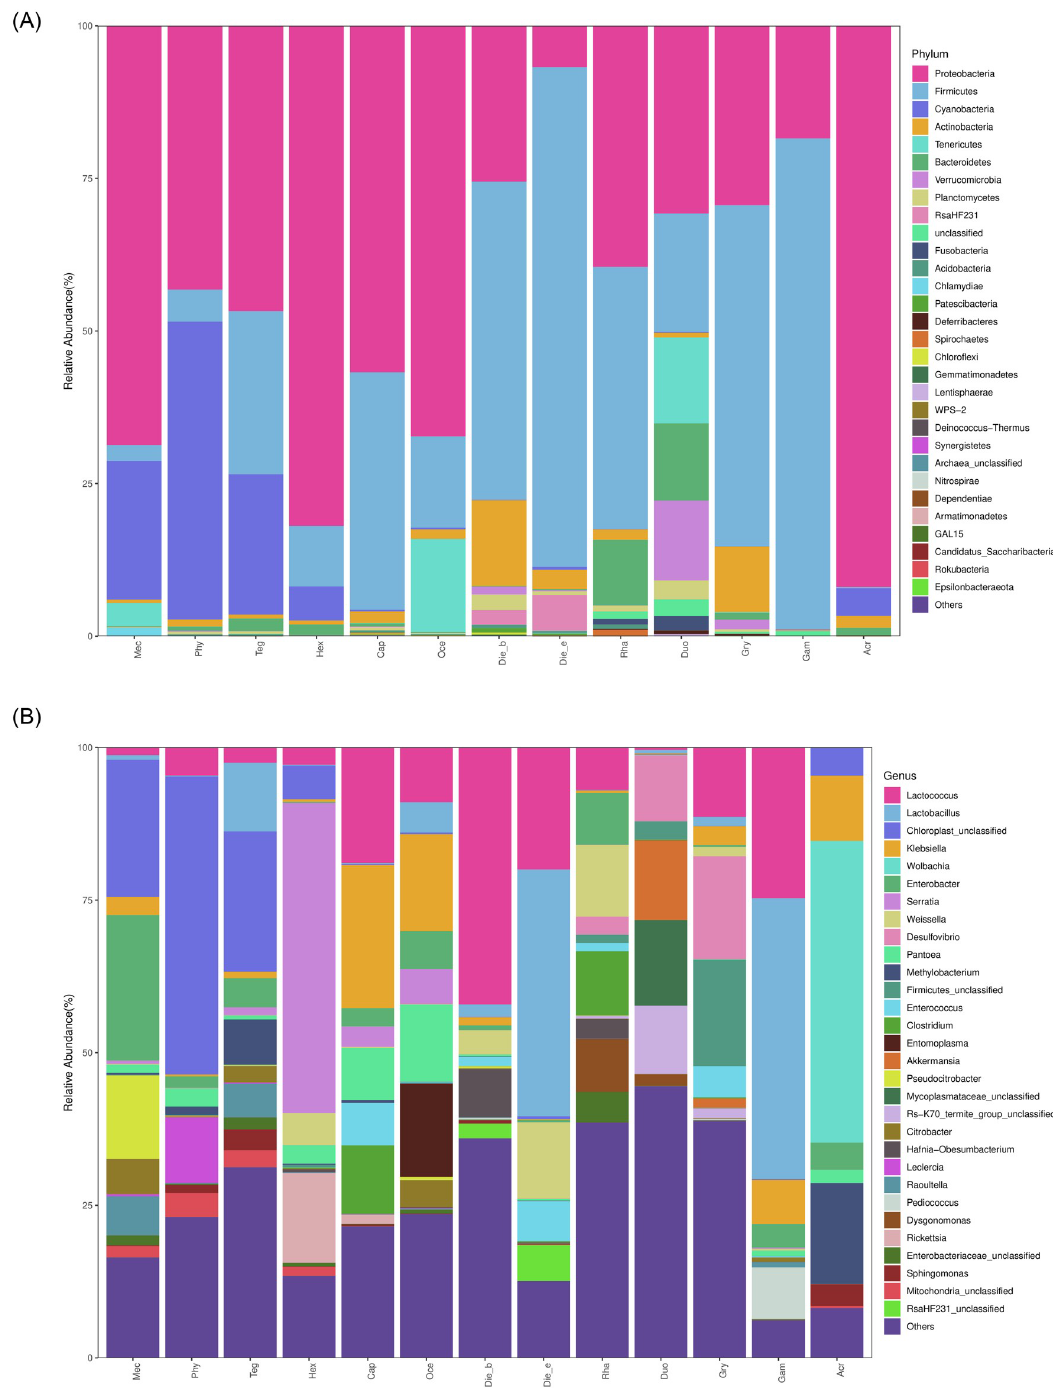
Fig 4. Bacterial community composition across samples at (A) the phylum and (B) the genus levels. Taxa without a top 30 abundant are indicated as others.